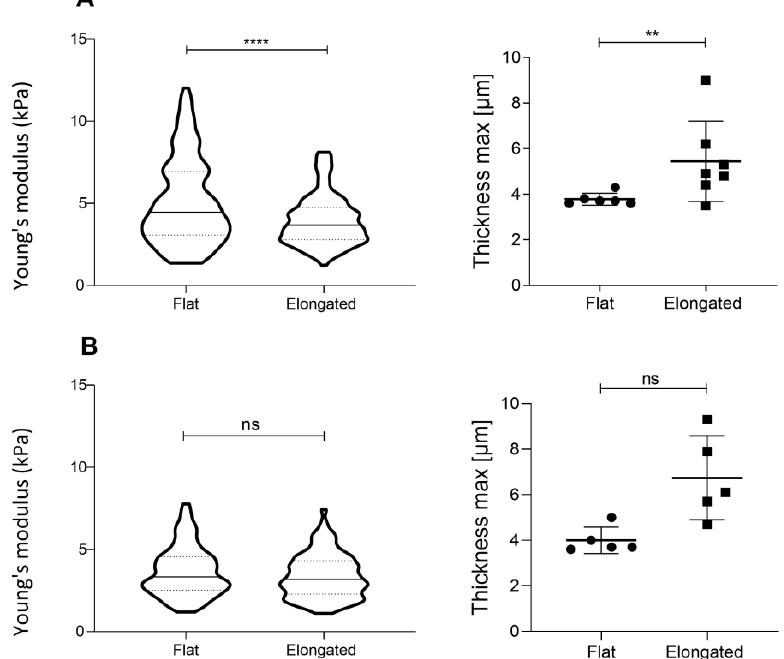
Figure 9. Young’s modulus dependence on cell shape. ( A ) Example of cell line showing differences in cell shape correlating with elasticity values and cell thickness (line 1). ( B ) Example of a cell line where